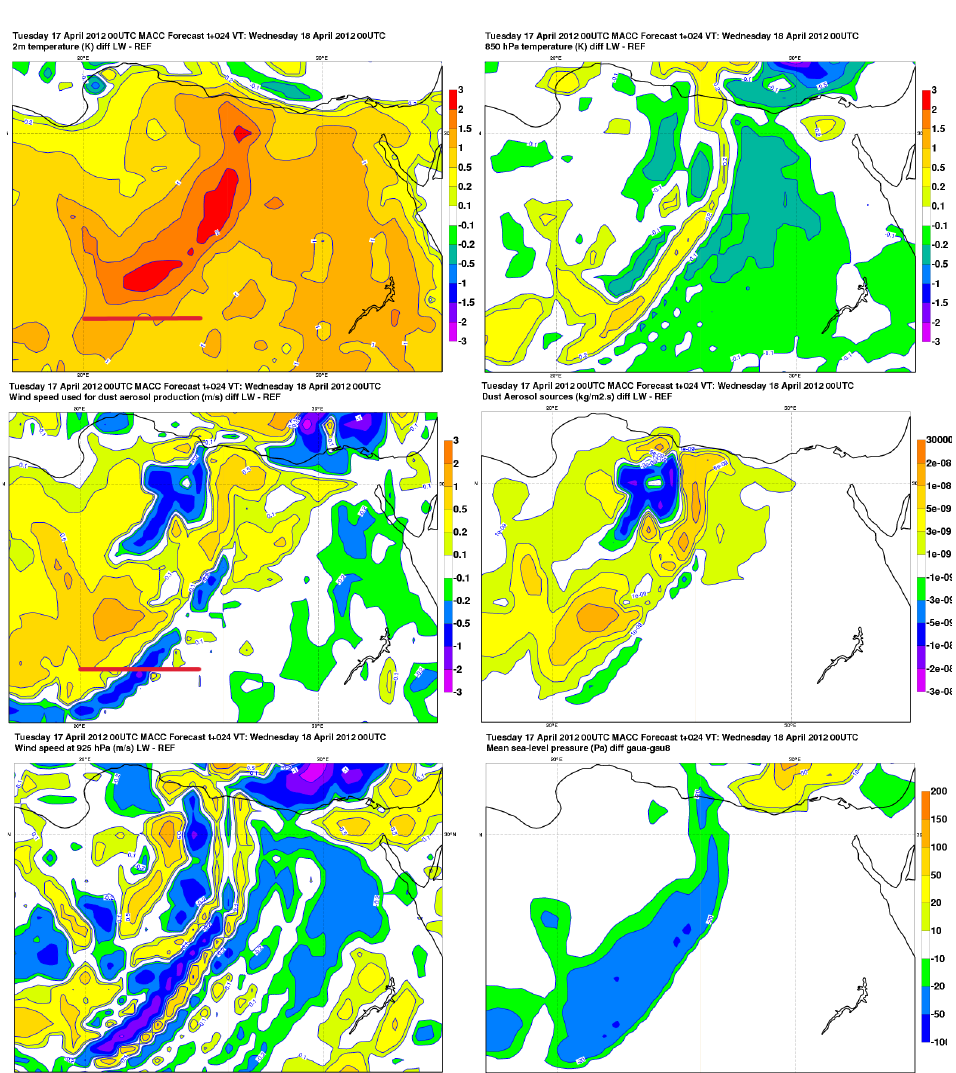
Figure 12. Simulations starting on 17 April 2012, 24h forecast. Difference of LW–REF for 2m temperature (top left), 850hPa temperature (top right), 10m wind speed (middle left), dust production (middle right), wind at 925hPa (bottom left) and sea-level pressure (bottom right). The red line on the 10m wind speed and 2m temperature panels indicates the cross section of Fig.